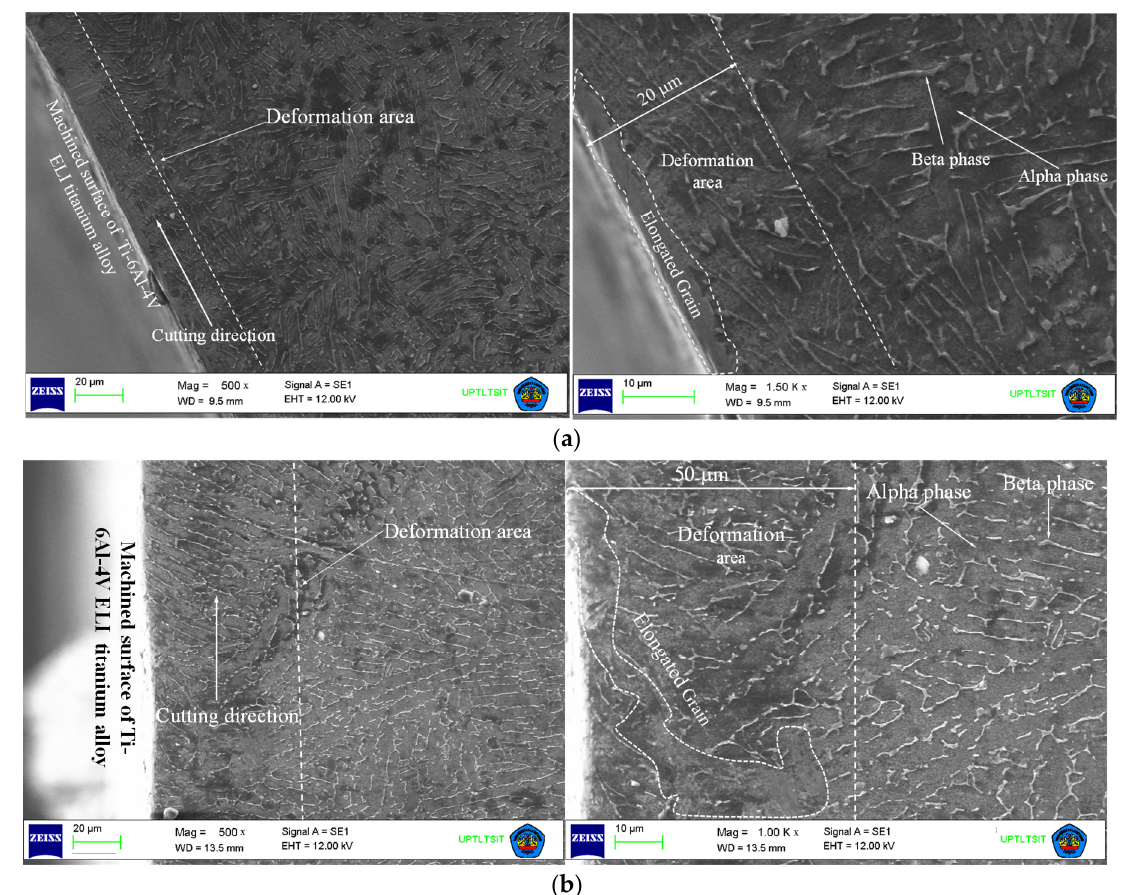
Figure 10. Microstructure of Ti-6Al-4V ELI at the cross-section: ( a ) cutting speed of 60 m/min; ( b ) cutting speed of 210 m/min.